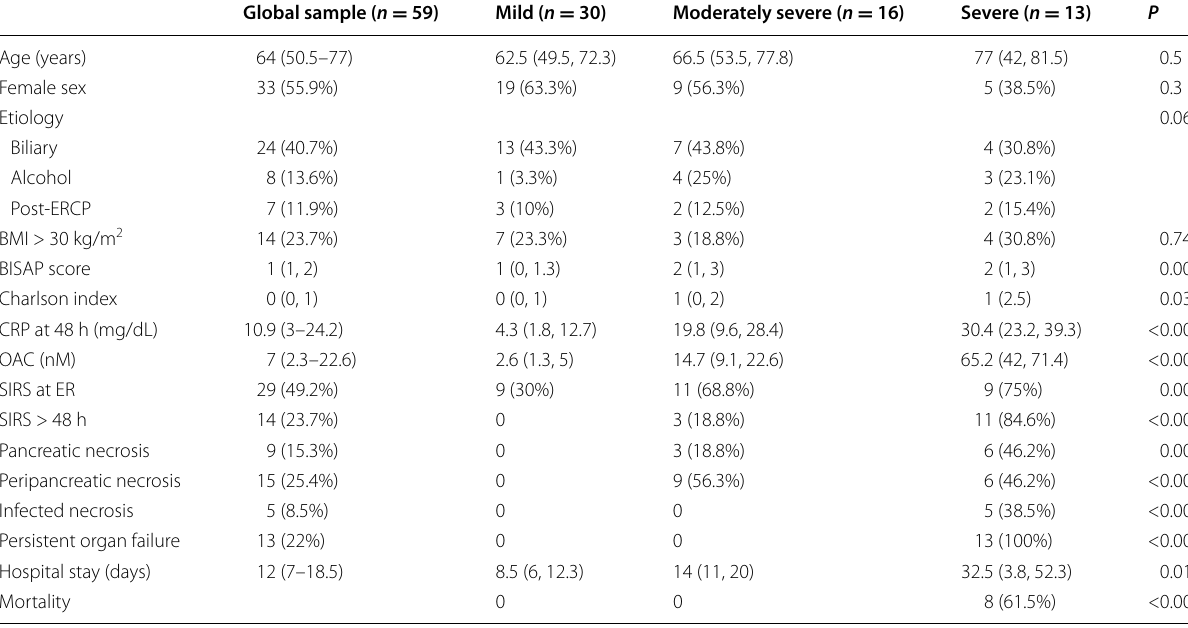
Results in median (p25, p75) or n (%)